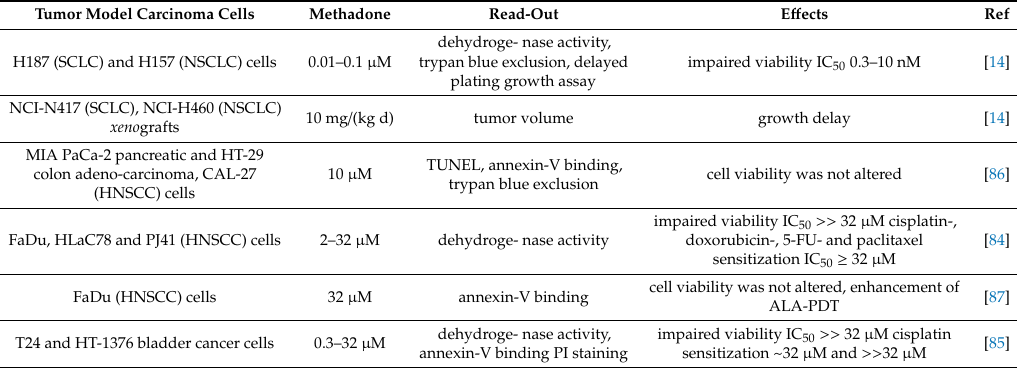
Table 3. Tumoricidal methadone e ff ects in preclinical studies as monotherapy or in combination with other anti-tumor